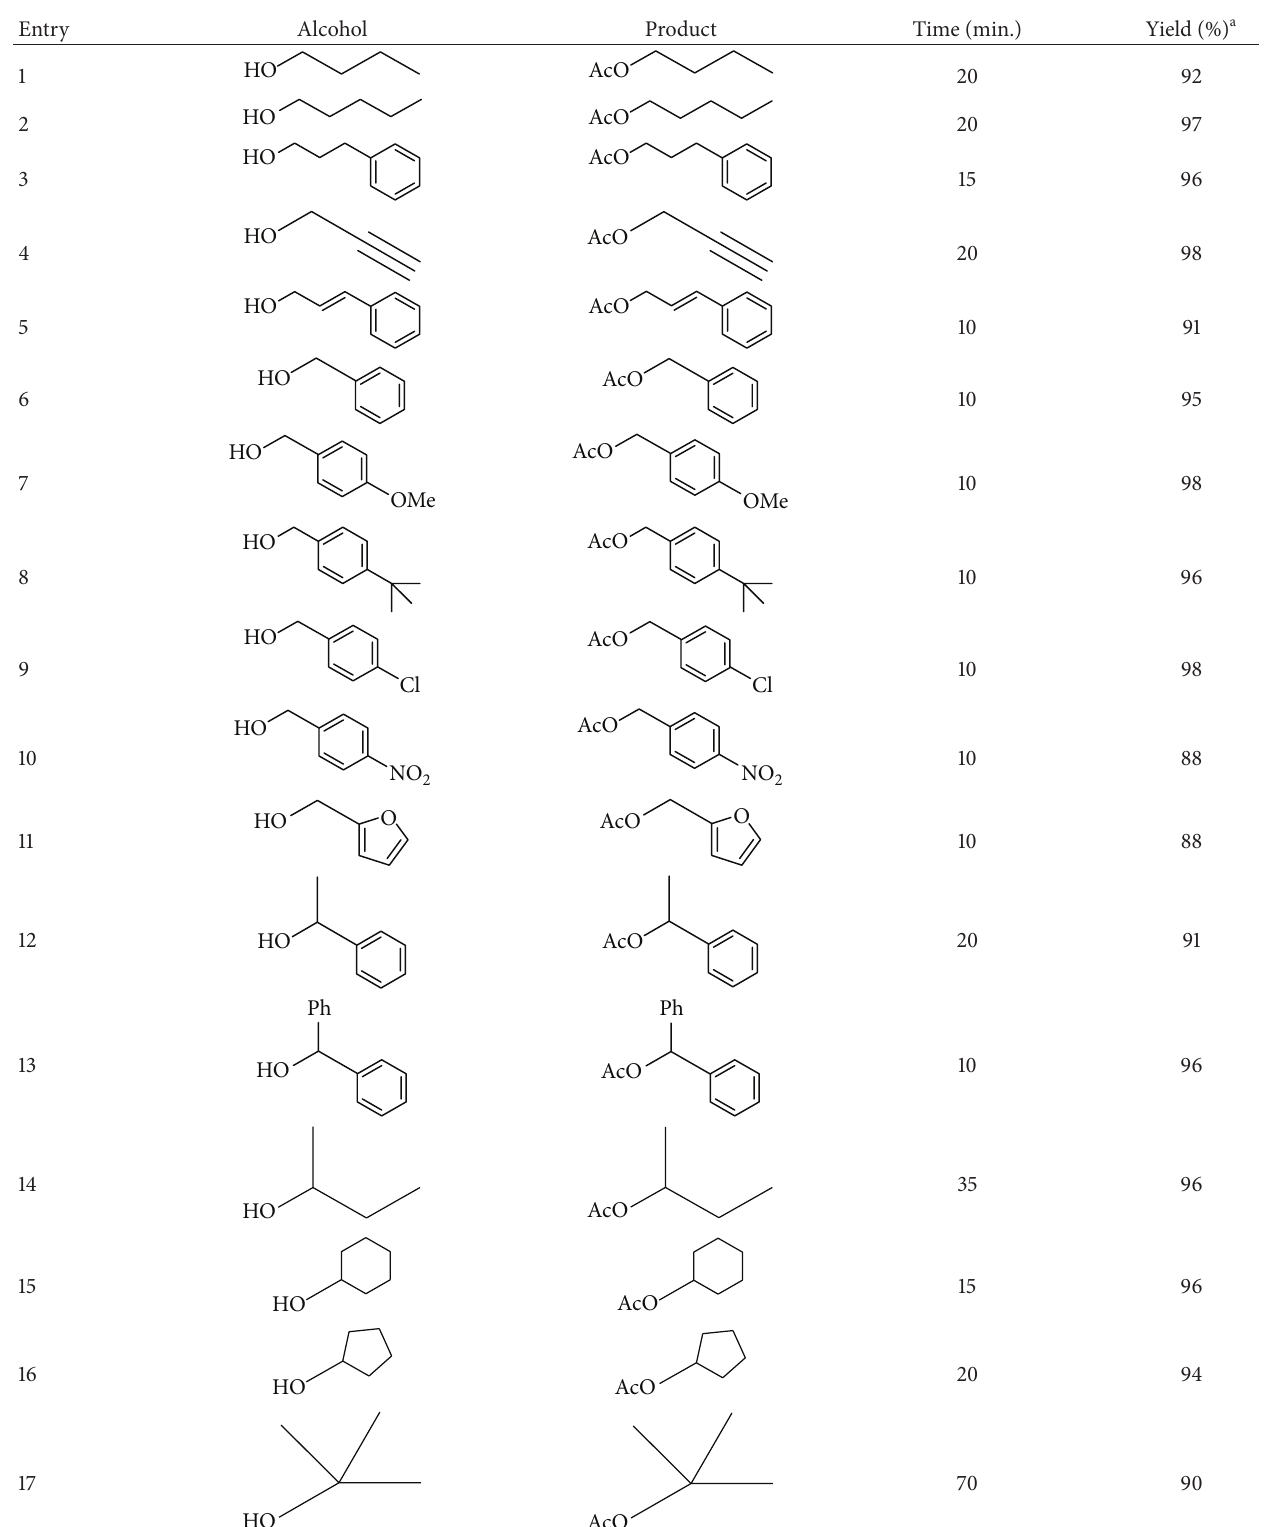
Table 1: Room-temperature NaOAc catalyzed acetylation of alcohols and